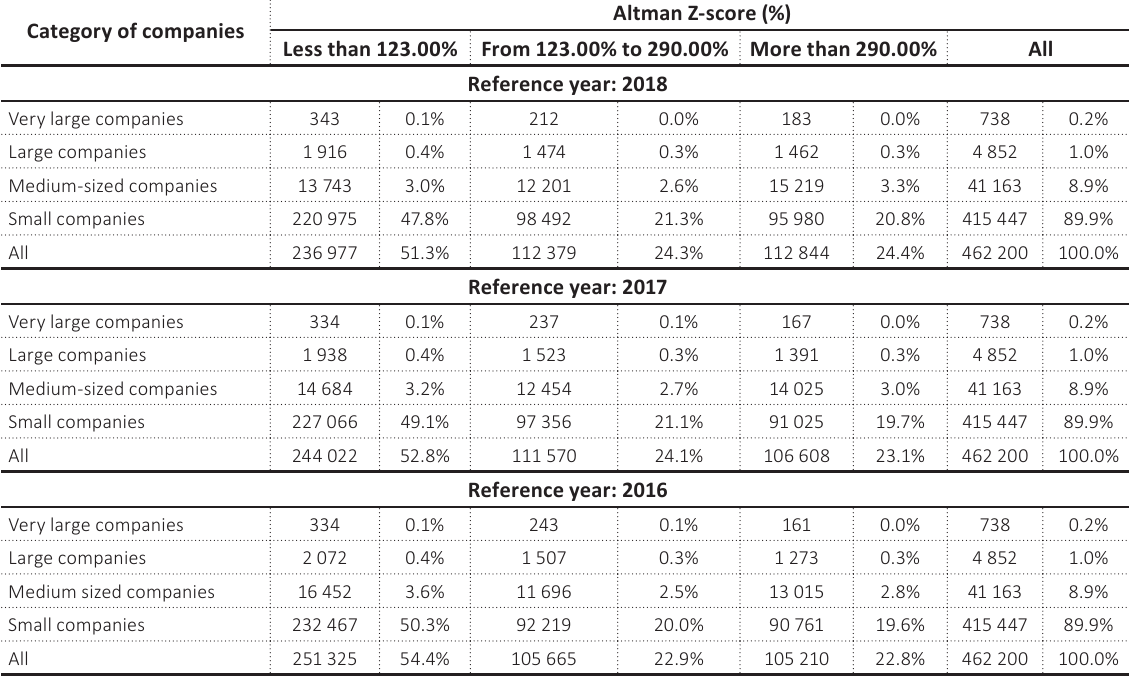
Source: Own tests based on company data from Amadeus. Altman Z-score